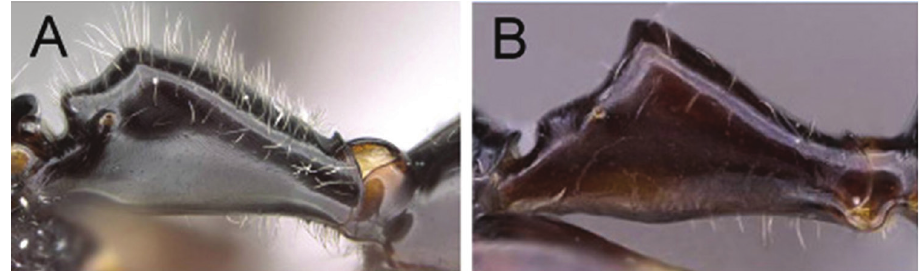
Figure 6. Petiole in lateral view of A Camponotus longicollis (CASENT0191989), and B Camponotus karaha (CASENT0067555).